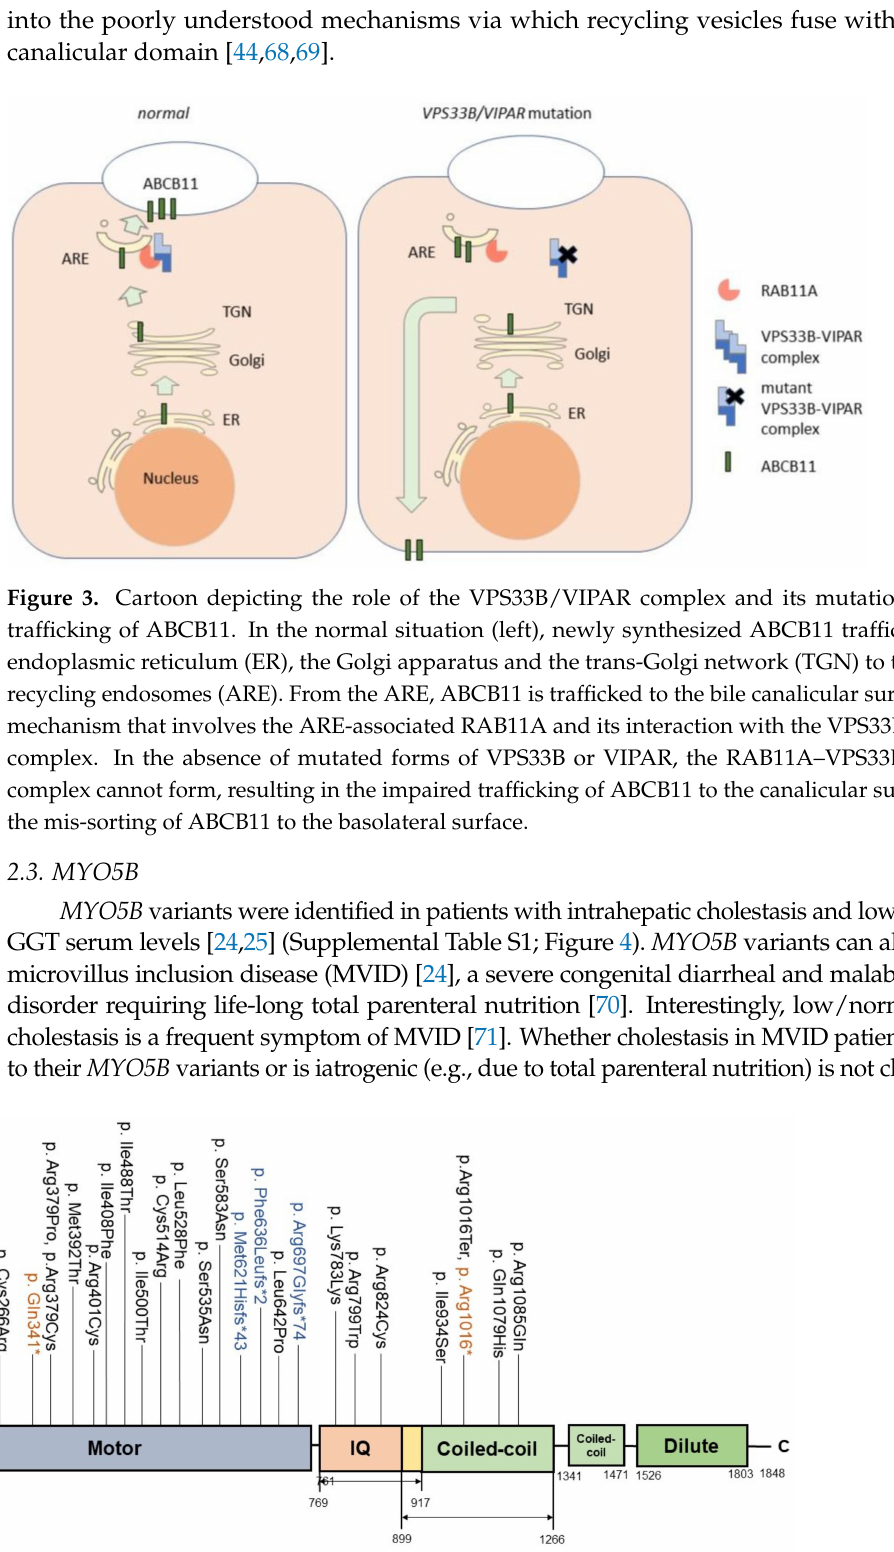
Figure 4. Cholestasis-associated myosin Vb mutations associated with the different myosin Vb protein domains. The protein domains include the motor domain (purple), the isoleucine/glutamine (IQ)-rich domain (orange), the coiled-coil domains (light green) and the Dilute domain (green). N: aminoterminus; C: carboxylterminus; AA: amino acid; *: premature